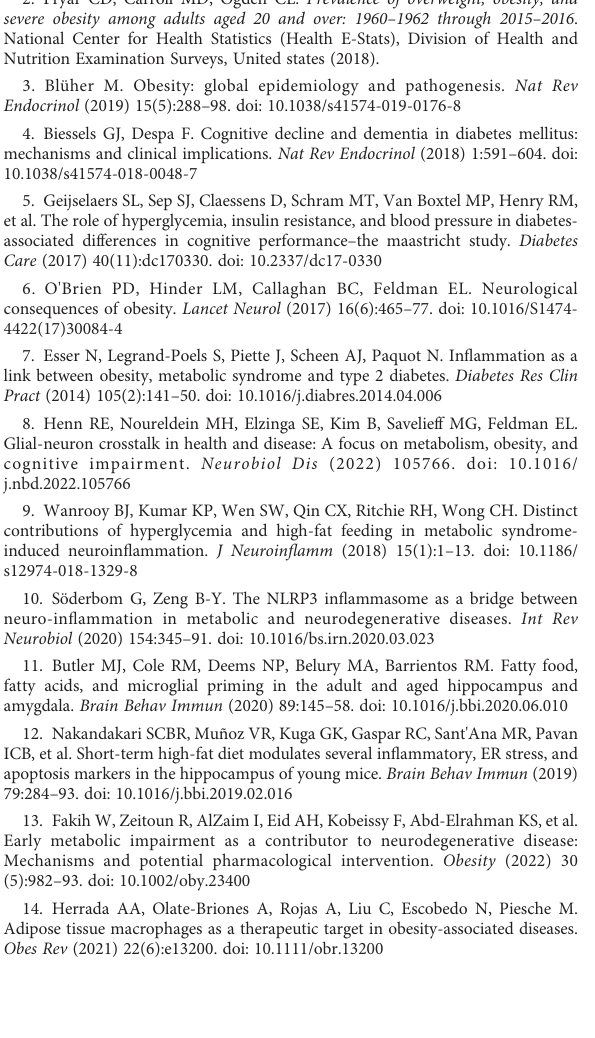
SUPPLEMENTARY FIGURE 10 Representative co-culture cGAS/STING western blot images. Representative unaltered images of western blots quanti fi ed in main fi gure 7 (w/link color) for cGAS/STING pathway protein expression of cGAS (A) , STING (B) , pIRF3 (C) , NF kb (D) , and histone (F) in in palmitate (Palm) and insulin and palmitate (IP) stimulated neuronal and